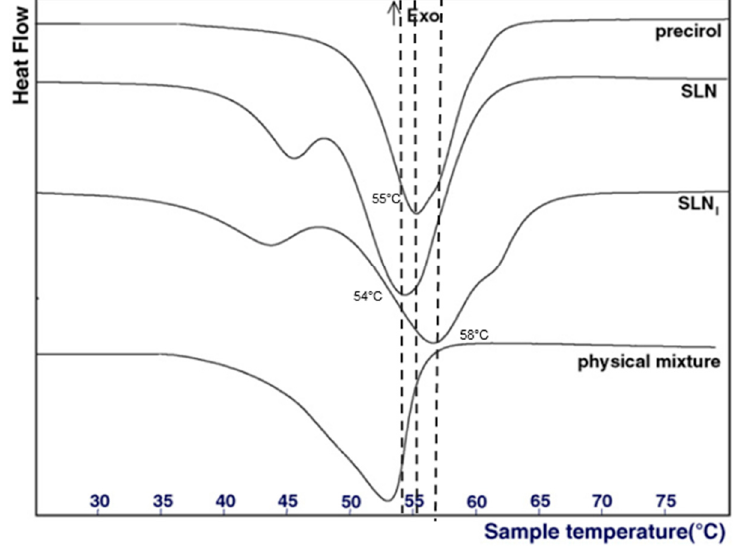
Figure 3. DSC profiles of pure precirol, empty SLN, ibuprofen-loaded SLN (SLN i ) and a mixture of precirol and ibuprofen. Adapted from [23].